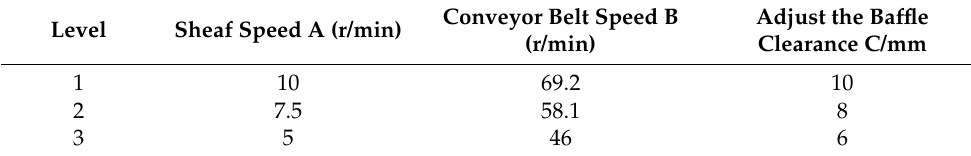
Table 1. Factor level table of orthogonal